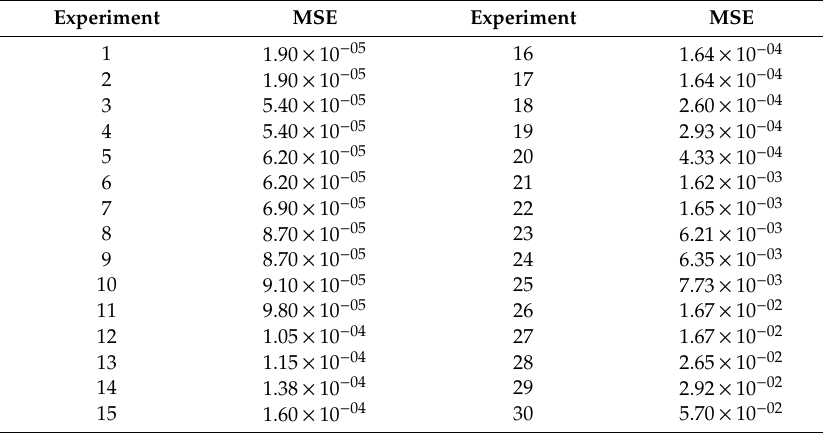
Table 16. Results obtained with WDO.